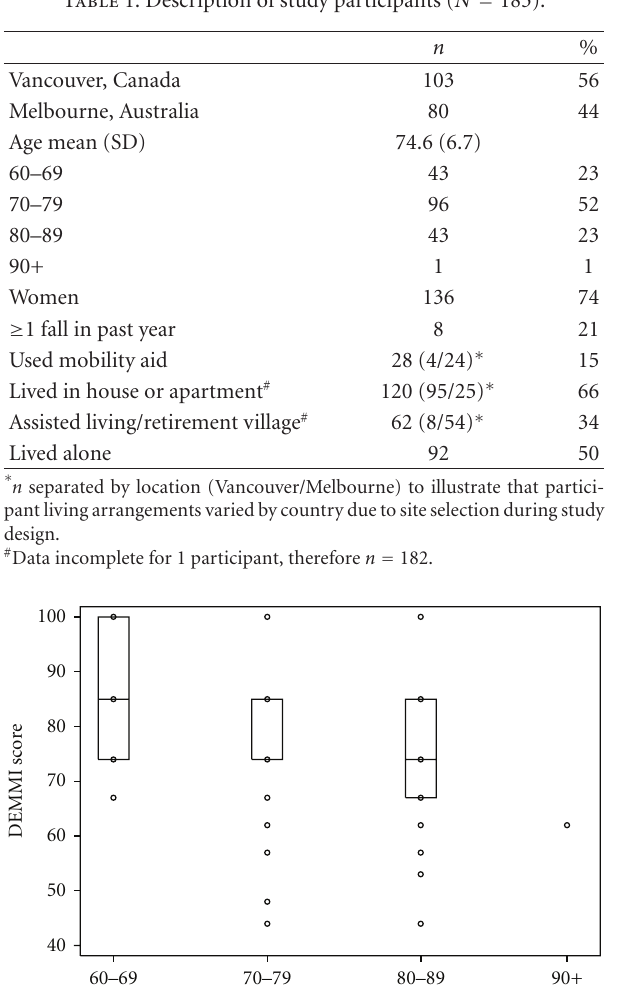
Table 1: Description of study participants ( N = 183).